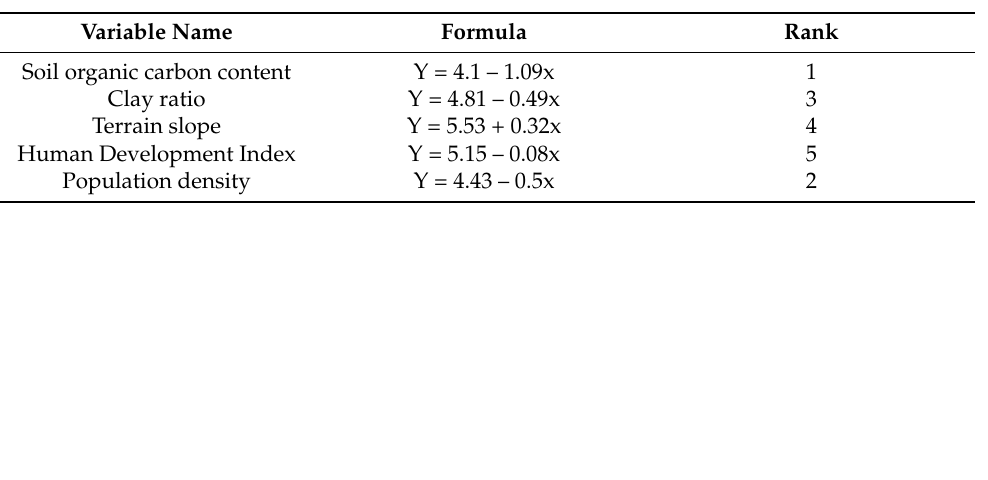
Table 4. Results of the sensitivity analysis of the selected soil-erosion